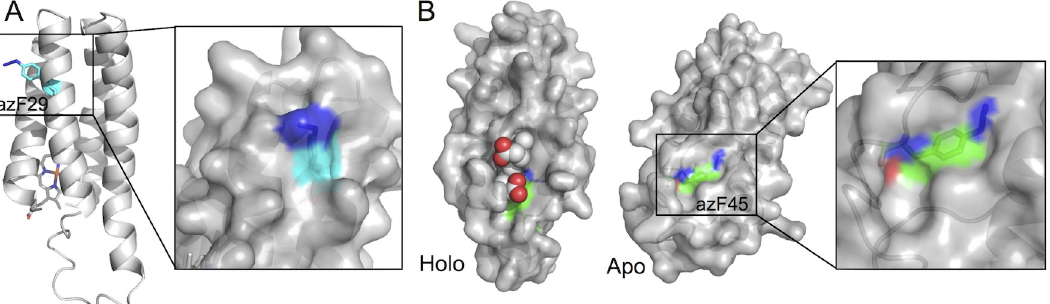
Fig 5. In silico modelling of azF cyt b 562 variants. (A) Models of the A29 azF holo cyt b 562 . The mutated residue, azF29, is coloured in cyan at its carbon atoms. The right hand panel is a close up surface view of the model. (B) Models of the P45 azF apo and holo cyt b 562 variant. The mutated residue, azF45, is coloured green at its carbon atoms. Haem is represented as spheres. The models were based on the PDB coordinate files 265B (Holo) and 1APU (apo). The figures where generated using PyMol [61].